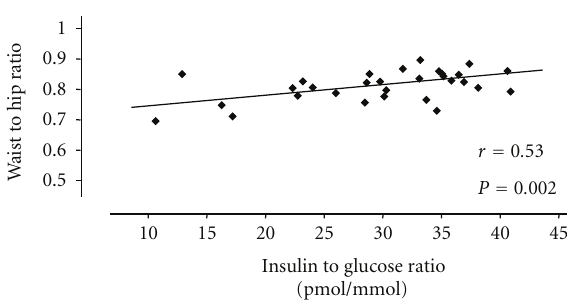
Figure 2: Relationship between body fat distribution and insulin resistance in patients with polycystic ovary syndrome. A signifi- cantly positive correlation between waist to hip ratio and insulin to glucose ratio is observed. Modified from Moran et al. [24].